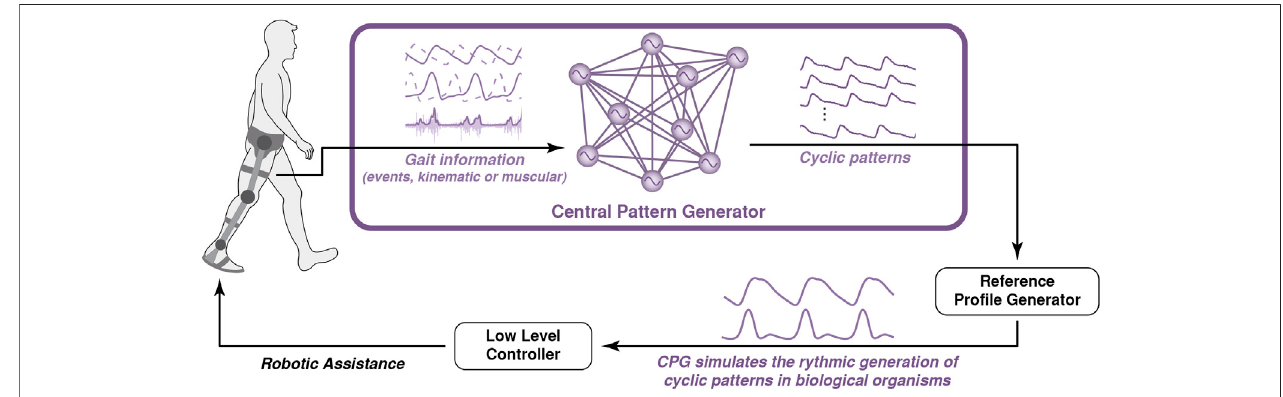
FIGURE 7 | Conceptual representation of the robot-gait coordination based on the use of a CPG: it estimates cyclic signals coordinated with the user ’ s gait that is used to generate the assistive pro fi le for the robot.